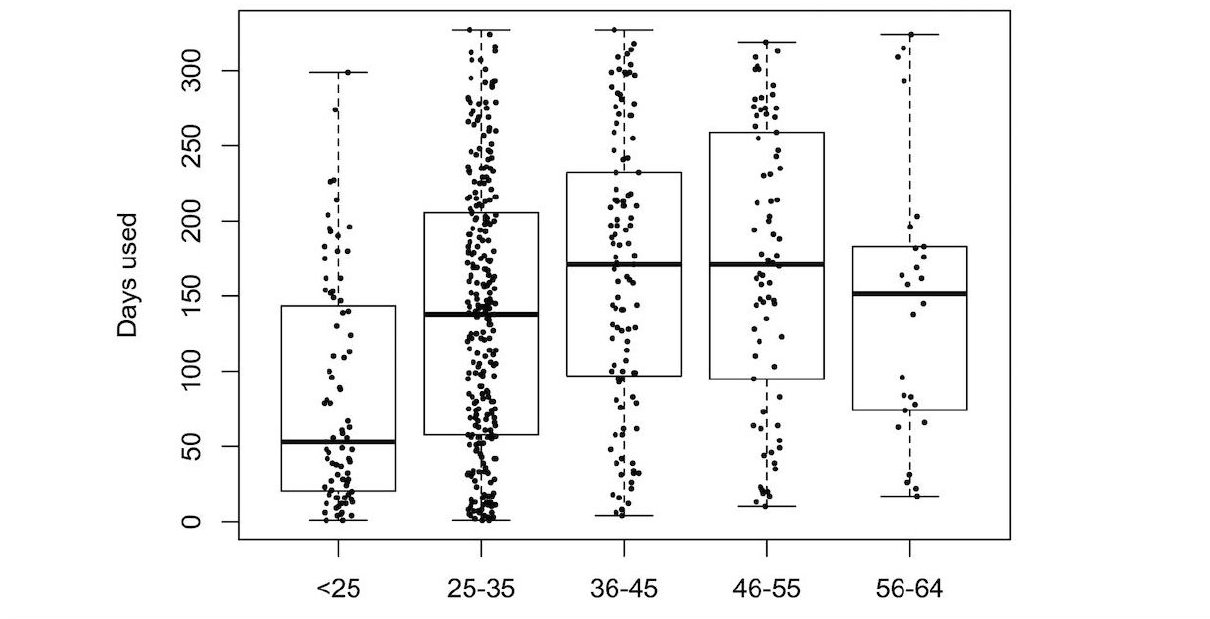
Figure 5. Boxplots of the distributions of Age levels. Older participants have longer sustained use.